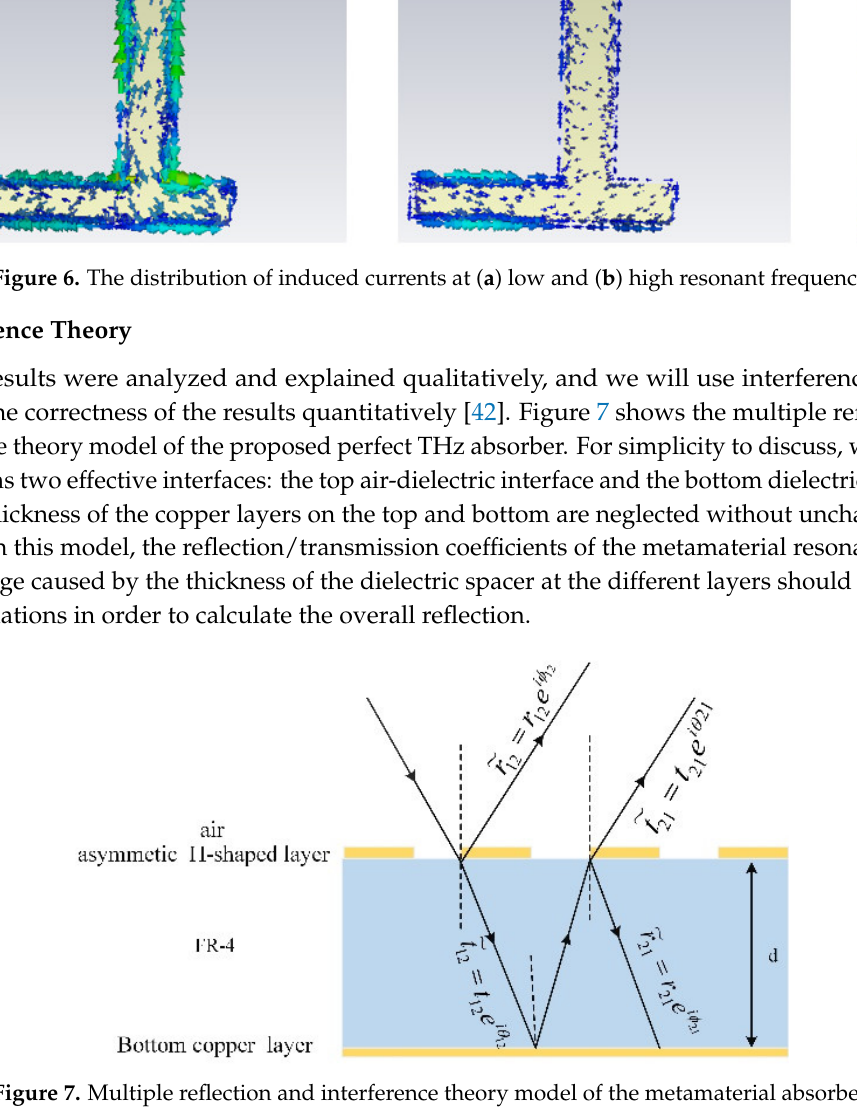
Figure 7. Multiple reflection and interference theory model of the metamaterial absorber.